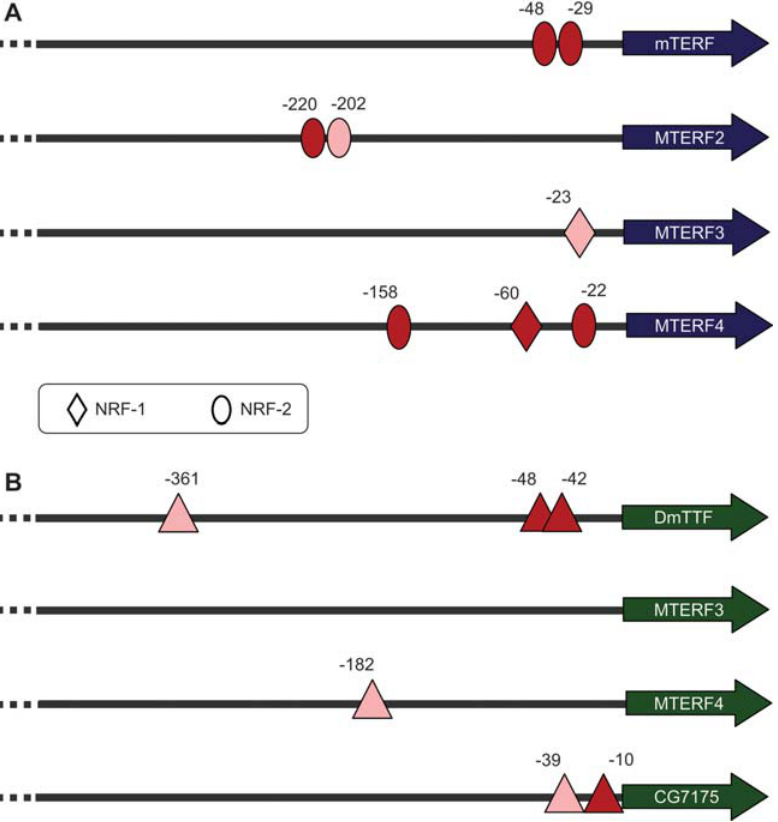
Figure 4 Location of binding sites for transcription regulatory factors predicted by MAPPER tool (45) in the promoter proximal region of genes coding for MTERF family proteins. Position numbers refer to the transcription start site of each gene, as deduced from mRNA sequence extracted by Ensembl search engine. Dark and light red symbols: high and low scoring sites, respectively. (A) Binding sites for NRF-1 and NRF-2 in human gene promoters. (B) Binding sites for DREF in Drosophila gene